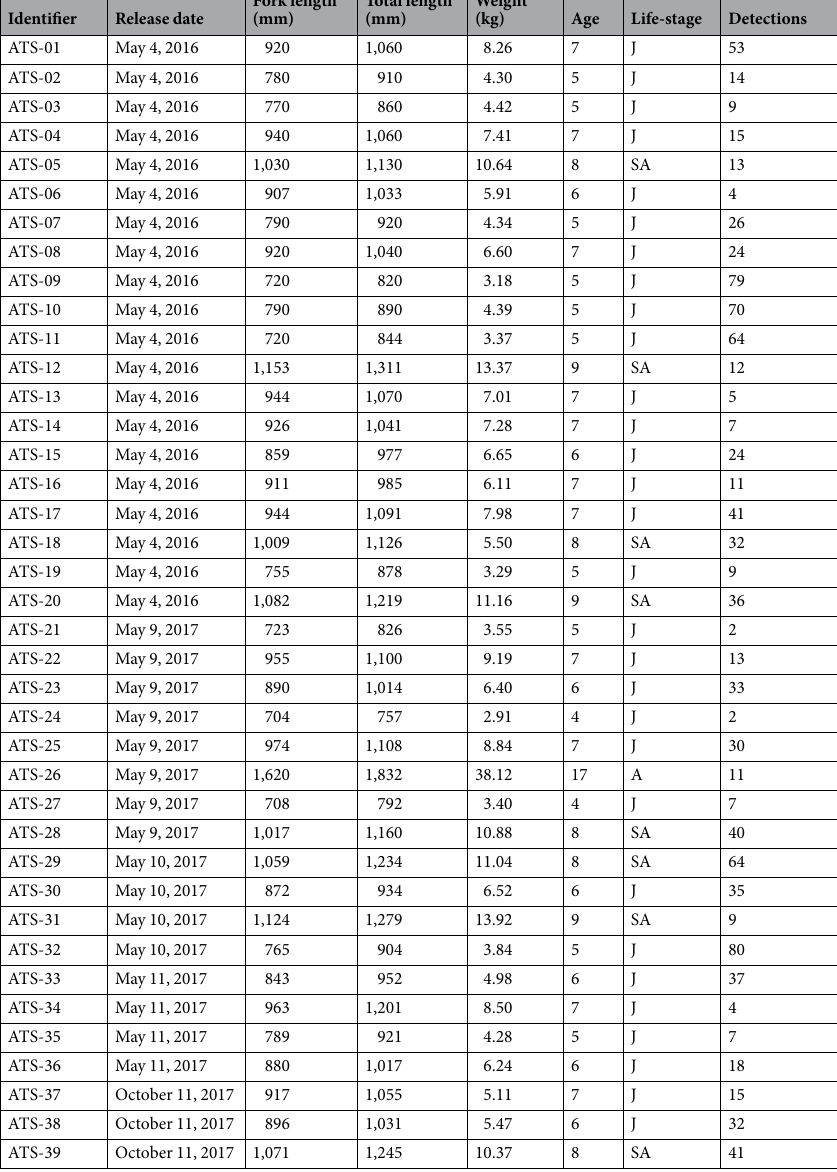
Table 1. Biological data associated with Atlantic Sturgeon tagged with acoustic transmitters May 4, 2016– October 11, 2017 that were subsequently detected in the New York Wind Energy Area study site (Equinor, Lease OCS-A 0512). Age-at-capture for individual fish was estimated using the von Bertalanffy growth function 46 and parameter estimates for Atlantic Sturgeon from the New York Bight distinct population segment ( L ∞ = 278.87, K = 0.057, t 0 = − 1.27) 47 . Note: J = juvenile (500–1,000 mm FL); SA = sub-adult (1,000–1,300 mm FL); A = adult ( > 1,300 mm FL); based on National Marine Fisheries Service permitting